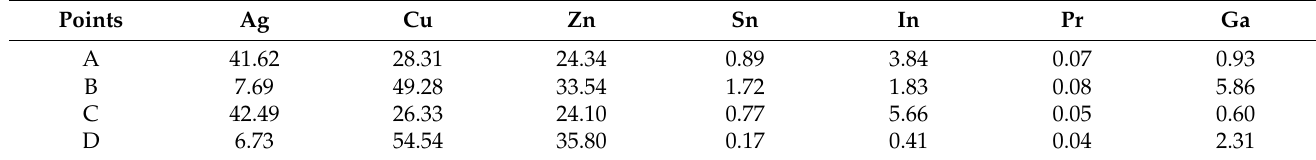
Table 2. EDS analysis of the points indicated in Figure 7